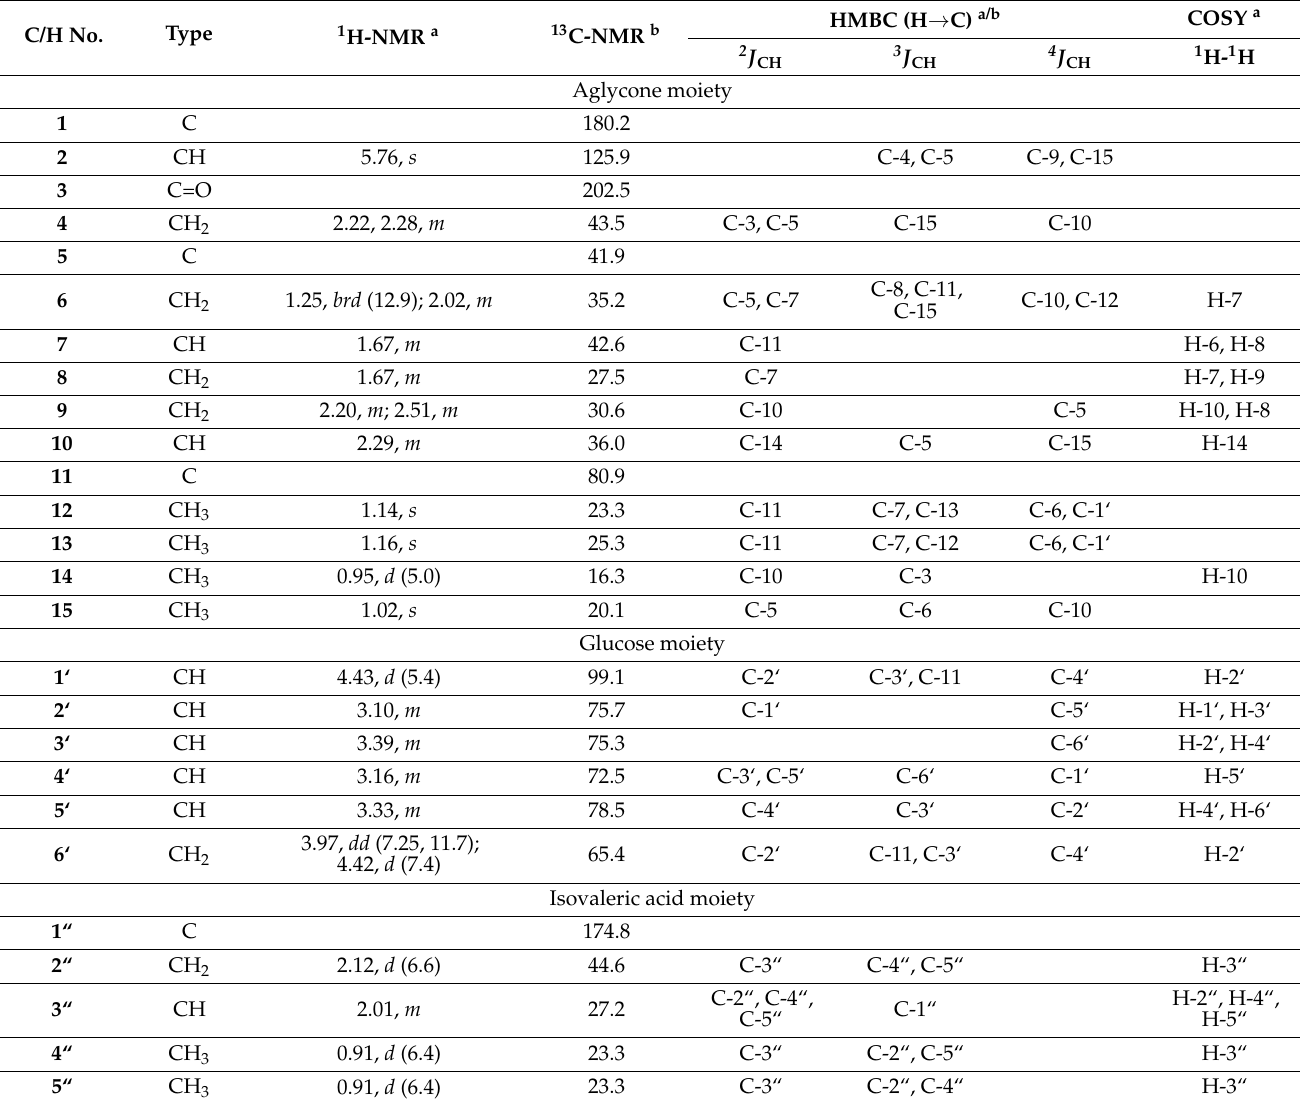
Table 2. NMR spectral data for the compound E5 in CD 3